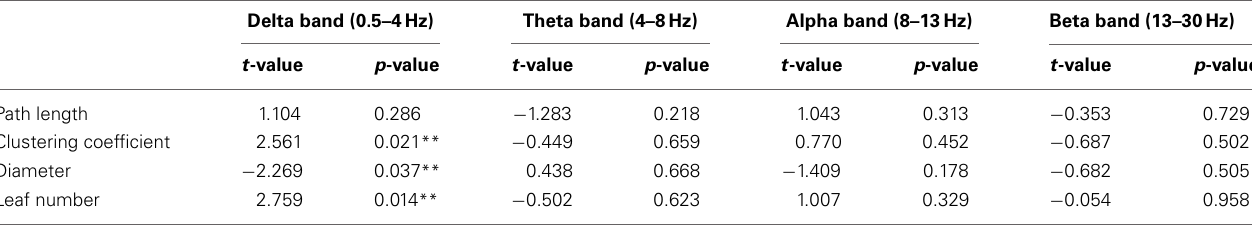
Table 3B | Paired t -test between EEG and SD-EEG recordings of controls for network measures (path length and clustering coefficient) and MST measures (diameter and leaf